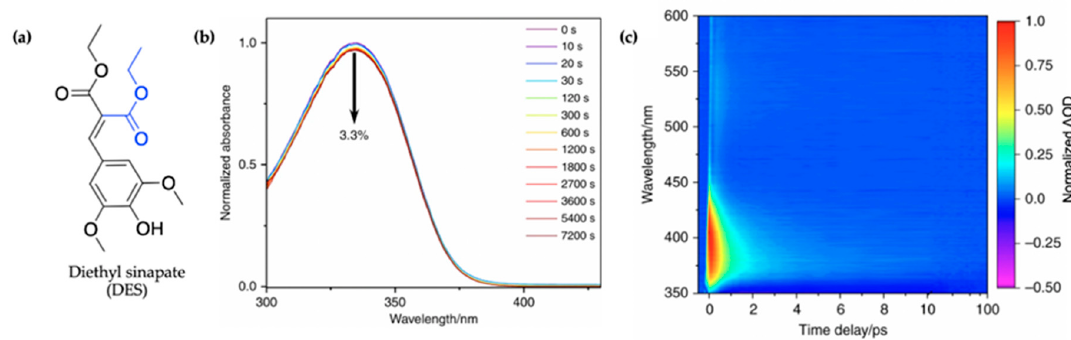
Figure 9. ( a ) Structure of diethyl sinapate (DES) with the group added to the monoester precursor of ES shown in blue. ( b ) Long-term photostability of DES. UV / visible spectra of DES in C12-C15 alkyl benzoate, at varying durations of irradiation at 335 nm and replicating solar intensity. ( c ) Normalized TAS displayed as a false colour map of DES in C12-15 alkyl benzoate (AB) deposited on a synthetic skin mimic (termed DES VC / AB), photoexcited at 335 nm. The timescale is plotted linearly from − 0.5 to 10 ps, then as a log scale from 10 to 100 ps. Reproduced and adapted with permission from [115] , licensed under CC BY 4.0. Published by Springer Nature.